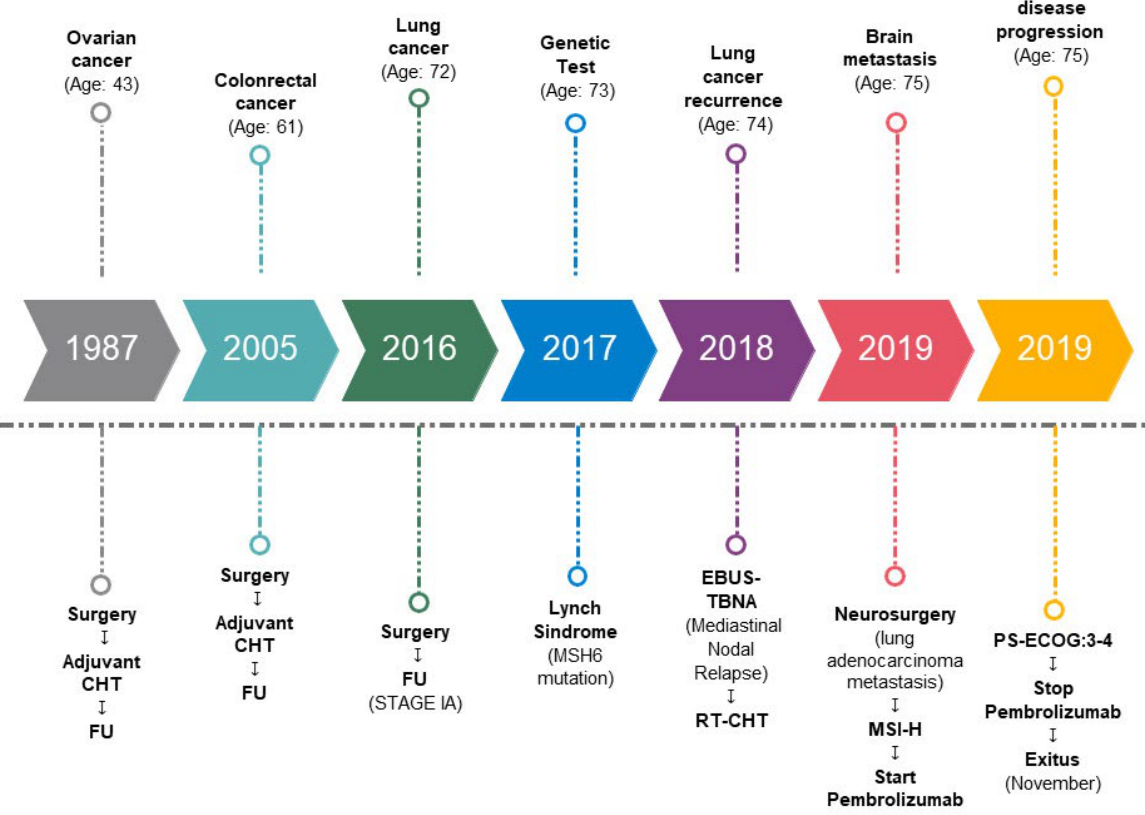
Explor Target Antitumor Ther. 2021;2:240-8 | https://doi.org/10.37349/etat.2021.00044